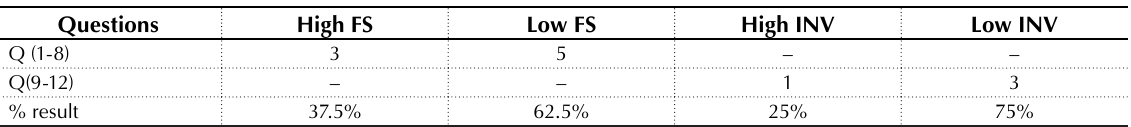
Table 7. Company (d)